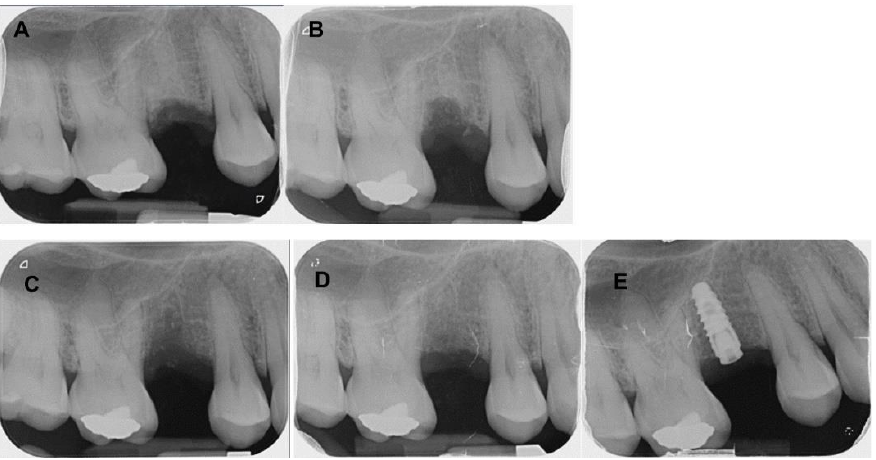
Figure 5. ( A ) Immediate postoperative periapical; ( B ) One week IOPA; ( C ) One month IOPA; ( D ) Two months IOPA; ( E ) IOPA after implant placement.